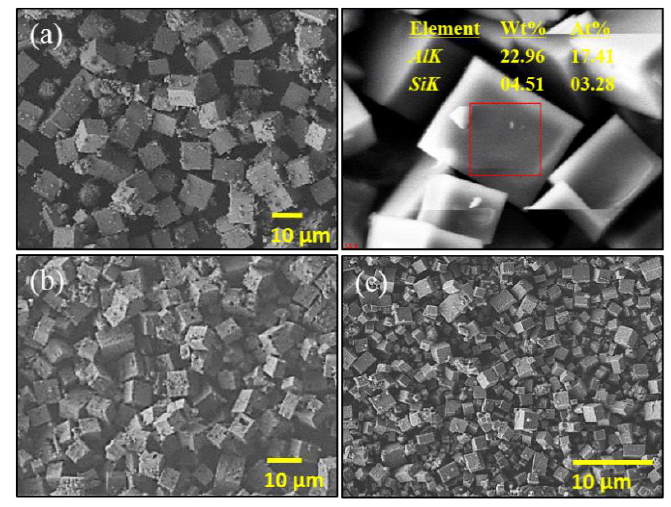
Figure 3. FESEM images of strongly acidic ( a ), moderately acidic ( b ), and weakly acidic ( c ) H-SAPO-34 zeolites. Top right shows the EDX results for strongly acidic H-SAPO-34.